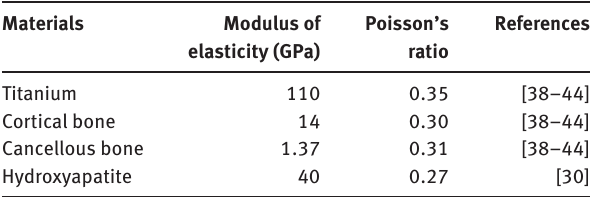
Table 2: Number of elements and nodes in dental implant models. Sample